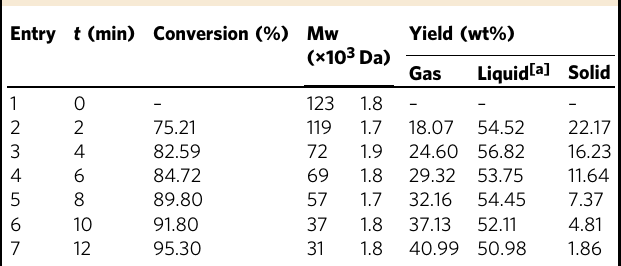
Fig. 1 Time-dependent reaction properties of plasma-assisted PS hydrogenolysis. a Product yield ( Y ) and conversion ( X ) and ( b ) gas product selectivity and ethylene yield as a function of reaction time ( t ). c 1 H NMR spectra and ( d ) GPC spectra of liquid products after different reaction time (PS-0min, PS- 6min, and PS-12min). Reaction conditions: ν H2 = 100 ml/min, P H2 = 101 kPa, P = 90 W. Table 1 A summary of product information after the reaction for different time. Reaction conditions: t = 4 min, ν H2 = 100 ml/min, P H2 = 101 kPa, P = 90